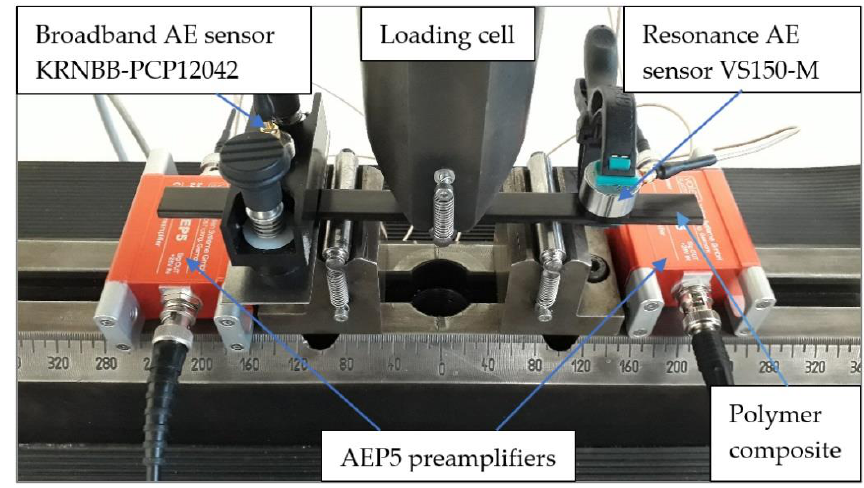
Figure 1. Experimental setup.